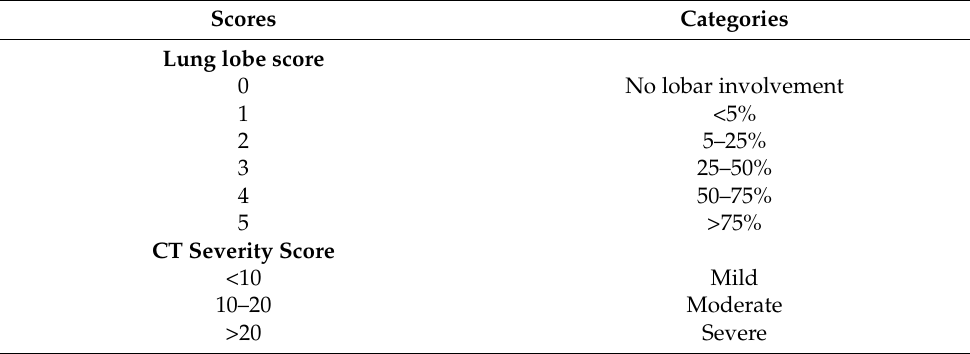
Table 1. Computed Tomography severity scores.